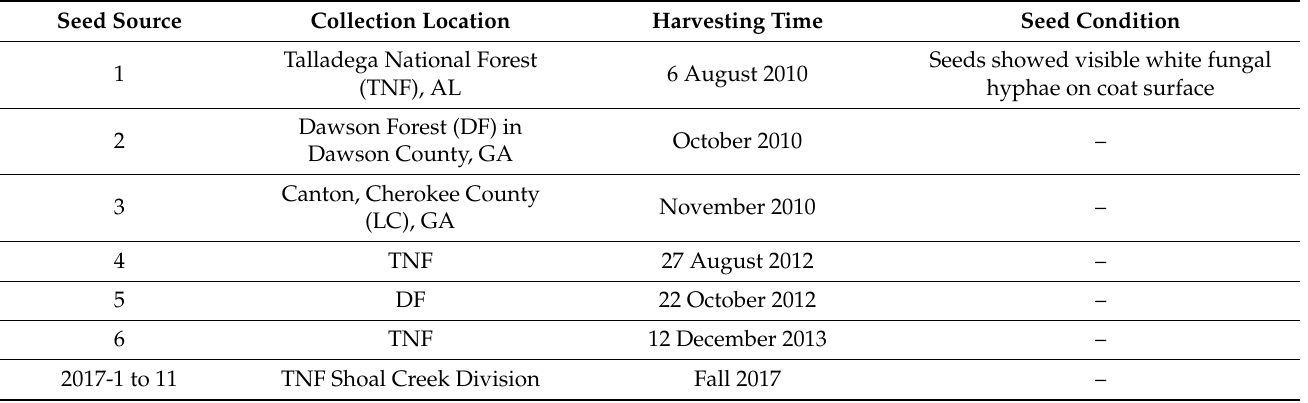
Table 12. Seed sources and sampling times for X. asphodeloides